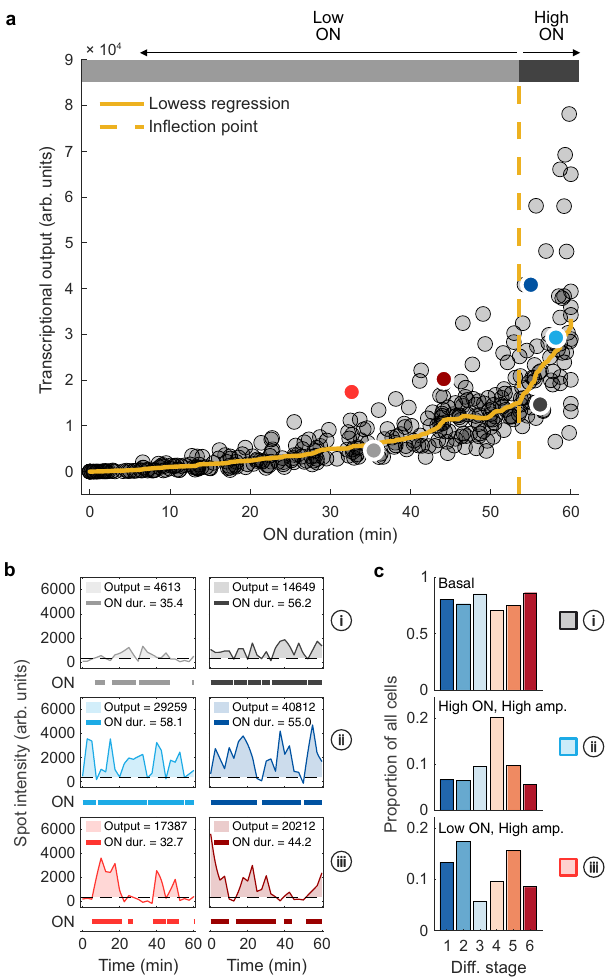
Fig. 5 | Changes in transcriptional behaviour during erythropoiesis. a Relationship between ON duration and total transcriptional output (area below thecurveandaboveONthresholdforentireimagingperiodforeachcell).LOWESS regression outlines the local relationship between these variables. The in fl ection point marks a step-change in the gradient of the regression. Cells above the in fl ection point we call ‘ High ON ’ cells, while those below are ‘ Low ON ’ . b Example spotintensitytracesforindividualcellsmarkedbycolouredcirclesin a .Beloweach panel, thick lines indicate when intensity traces for each cell are above ON threshold (dotted lines). The measured ON duration and output (shaded area) are given for each example cell. (i) ‘ basal amplitude ’ bursting; (ii) ‘ high ON, high amplitude ’ bursting; (iii) ‘ low ON, high amplitude ’ bursting. c Calculated propor- tions of cells with different bursting behaviours in b at each differentiation stage (de fi ned in Supplementary Fig. 10B,